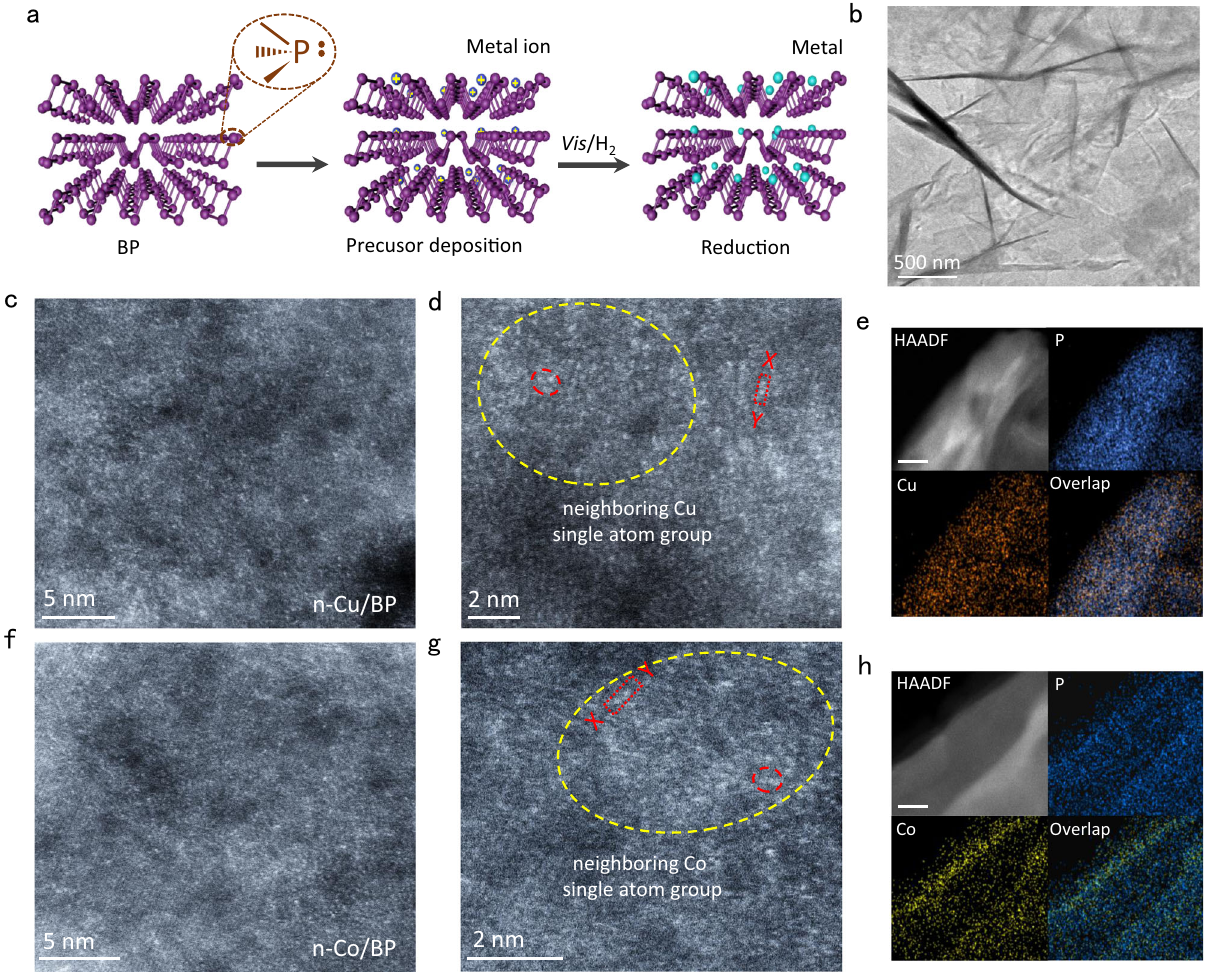
Fig. 1|Synthesisandcharacterizationoftheatomicallydispersedn-Cu/BPand n-Co/BP catalysts. a Schematic illustration of regulating the reactivity of BP when the lone-pair electrons of surface P atom coordinates with metal ions or single atoms (the atomic structure of BP was drawn by Cinema 4D software).